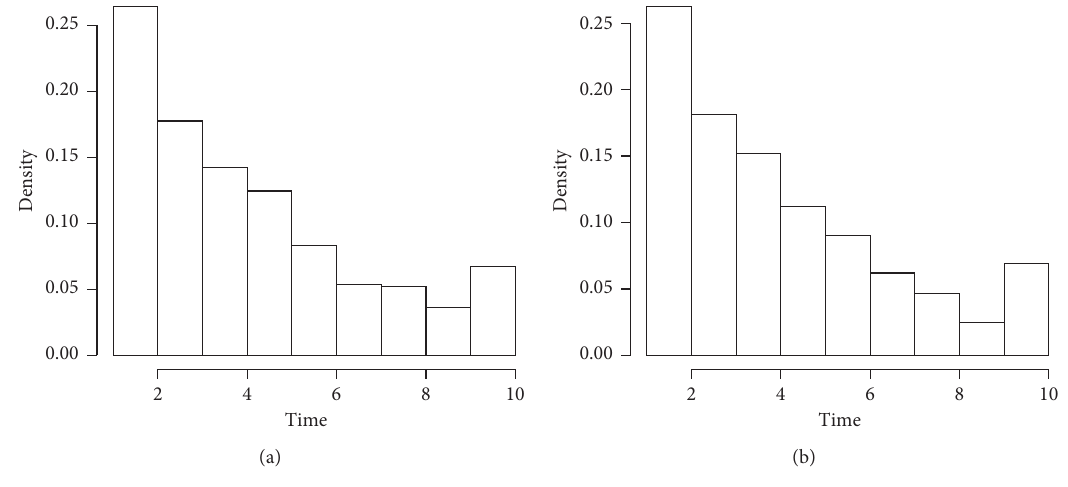
Figure 6: Histogram of the second jump